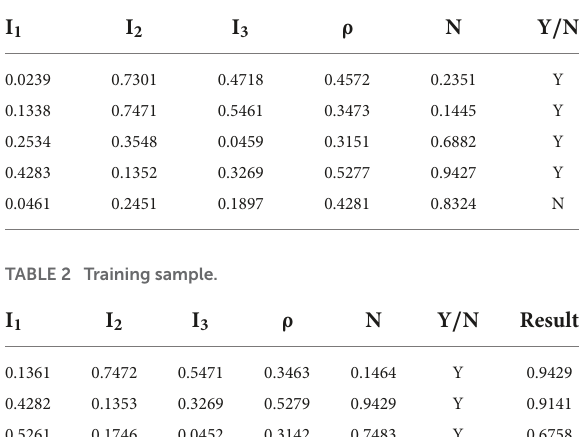
TABLE 1 Parameters of some training samples.